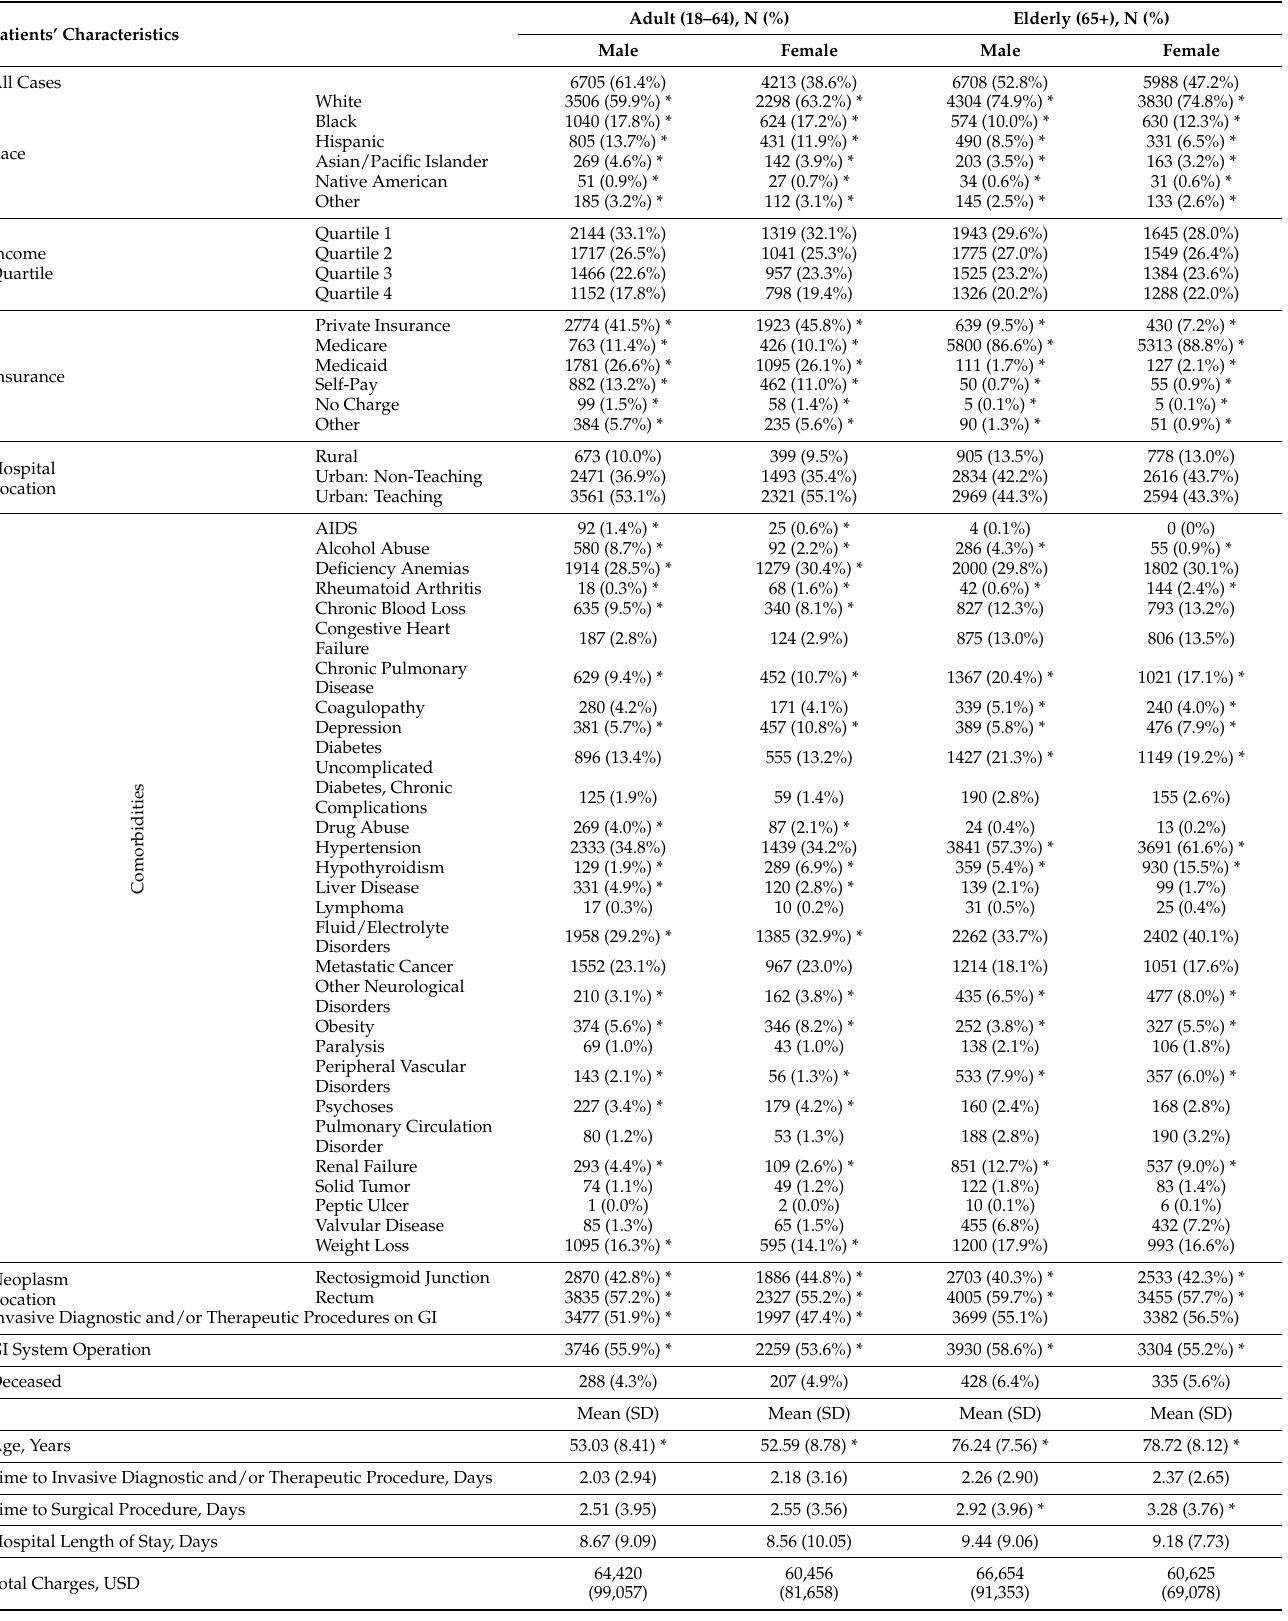
Table 2. Characteristics of emergency admitted patients with the primary diagnosis of malignant neoplasm of rectum or rectosigmoid junction. Data (NIS 2005–2014) were stratified according to sex categories. * p <